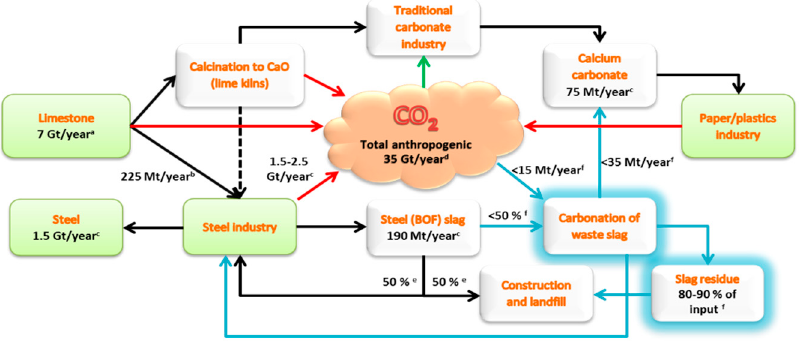
Figure 1. Typical annual mass flows of anthropogenic CO 2 and steelmaking slags, paper/plastics and limestone rock from a viewpoint of precipitated calcium carbonate (PCC) production.